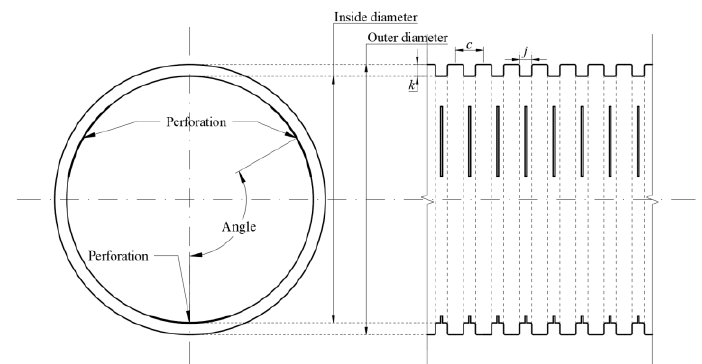
Figure 3. Particle size distribution of the test soil.